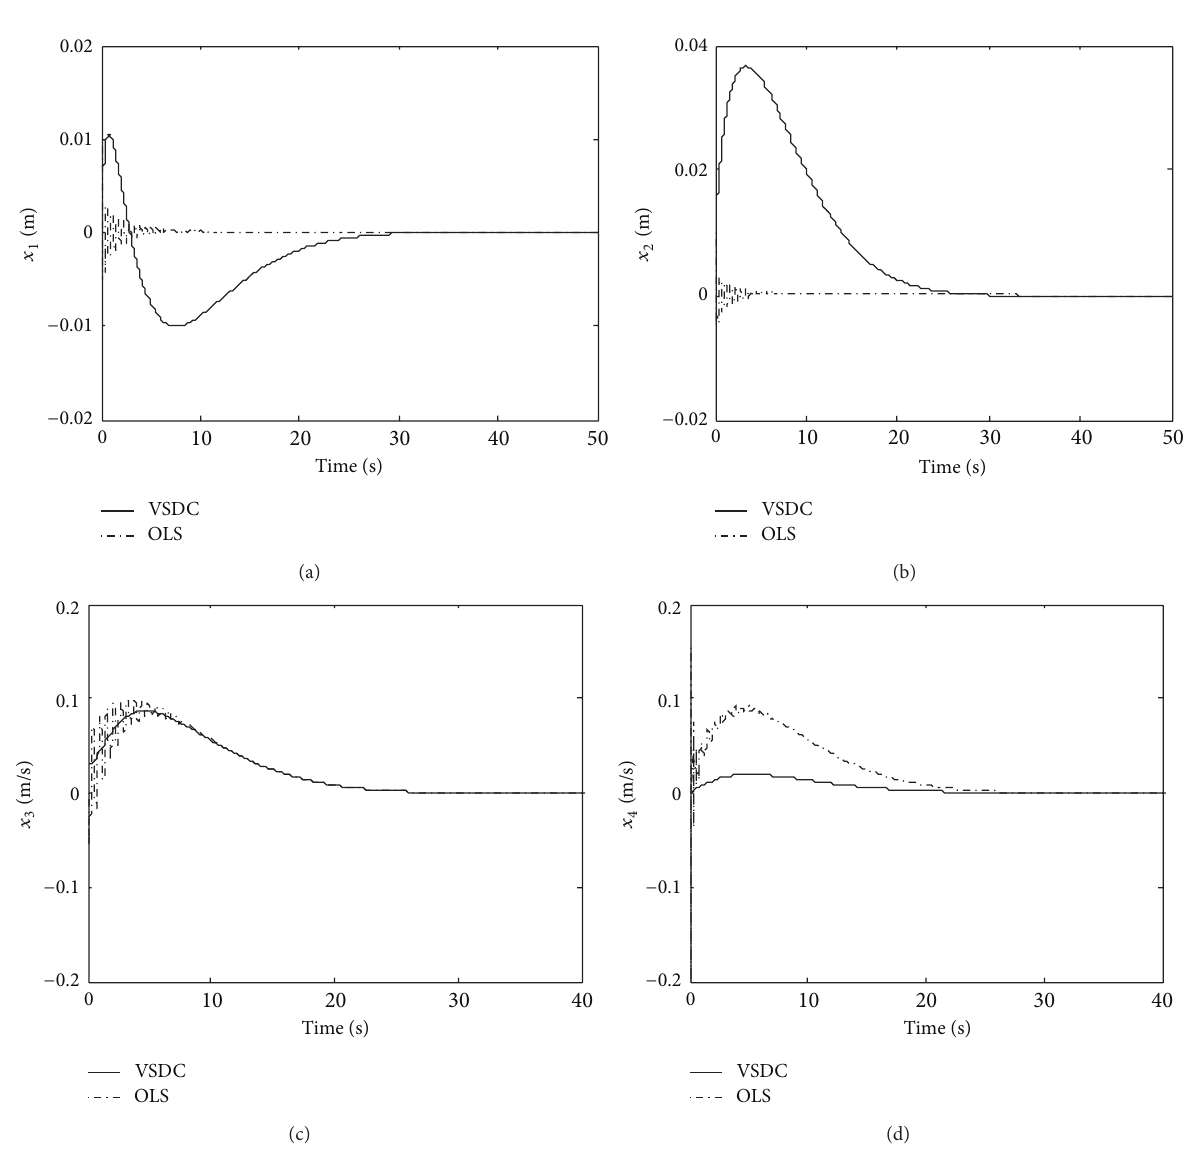
Figure 3: States trajectories of VSDC and OLS under attenuated